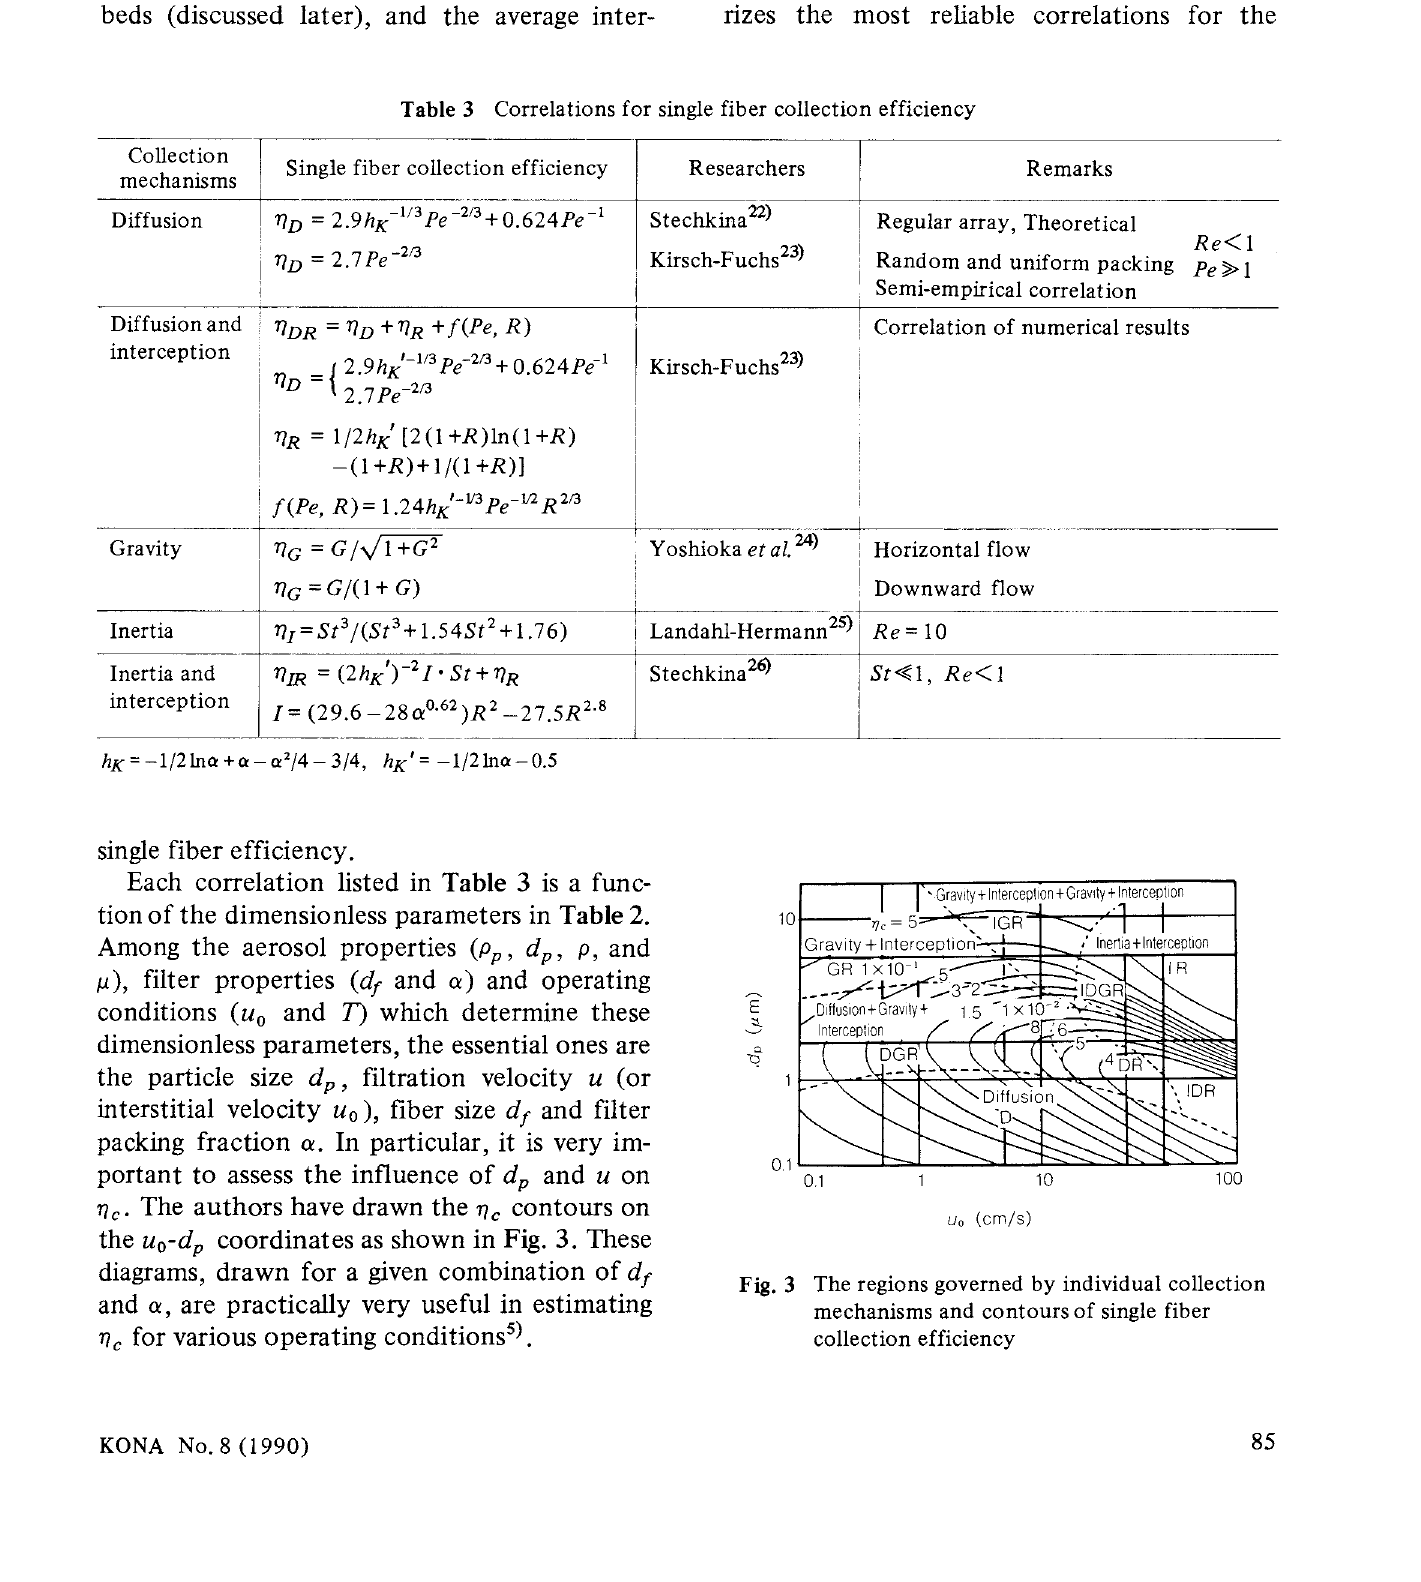
Table 3 Correlations for single fiber collection efficiency